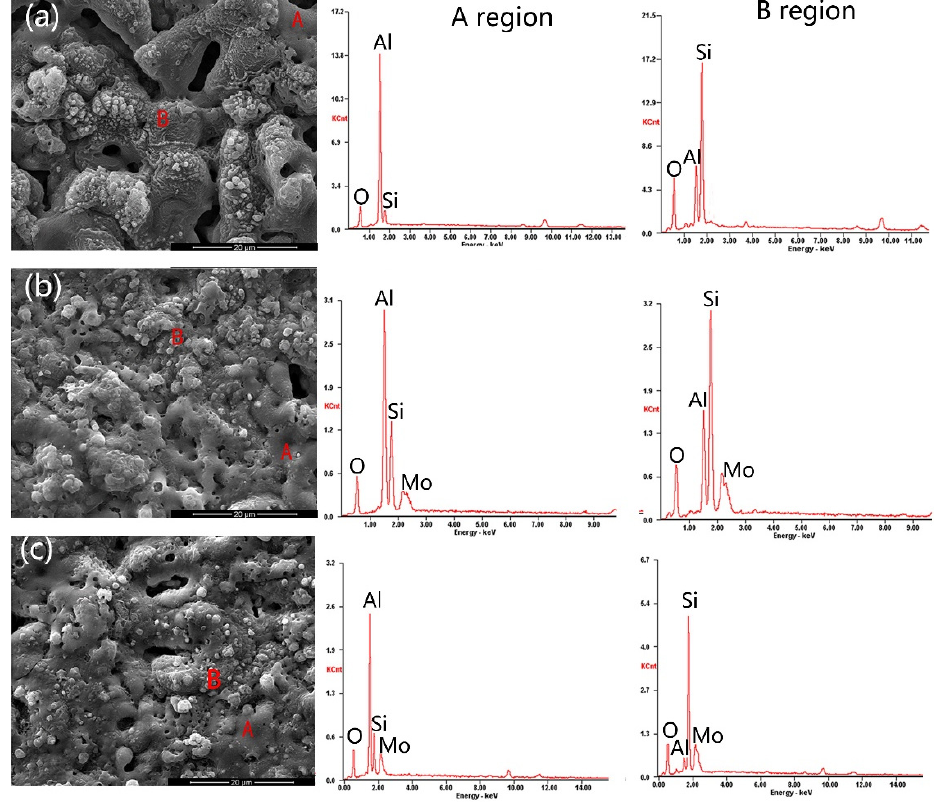
Figure 1. SEM morphologies and EDS of the MAO coatings: ( a ) coating A, ( b ) coating B, ( c ) coating C.